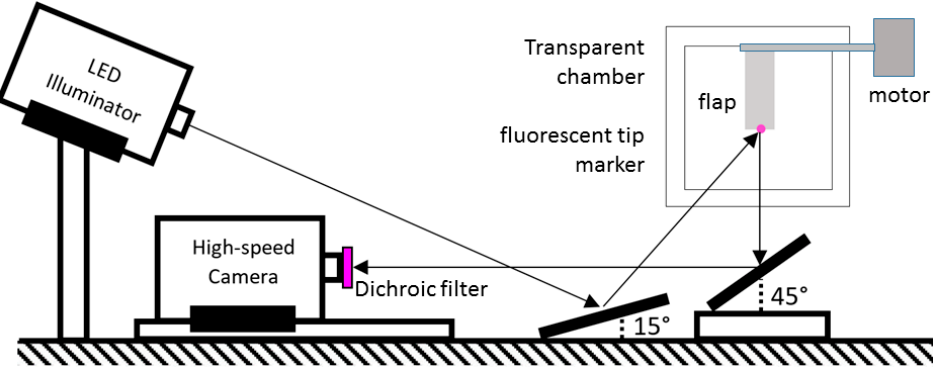
Figure 2. Schematic view of the optical set-up to record the tip motion of the artificial cilia. Fluids 2018 , 3 , x FOR PEER REVIEW